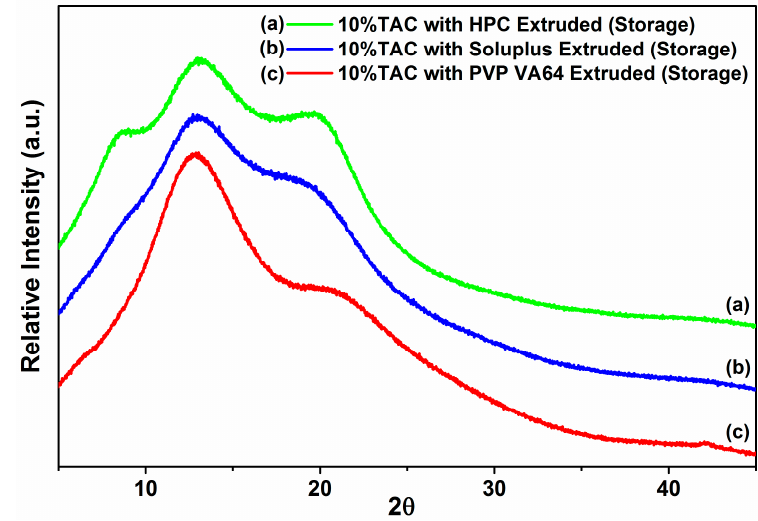
◦ C and 75% RH for 3